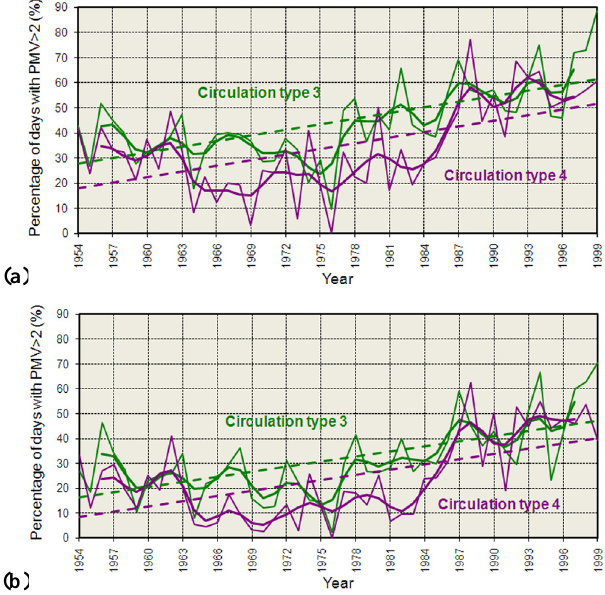
Fig. 10. As in Fig. 2 but for circulation types 3 and 4 and in per- centages (%) and for the period